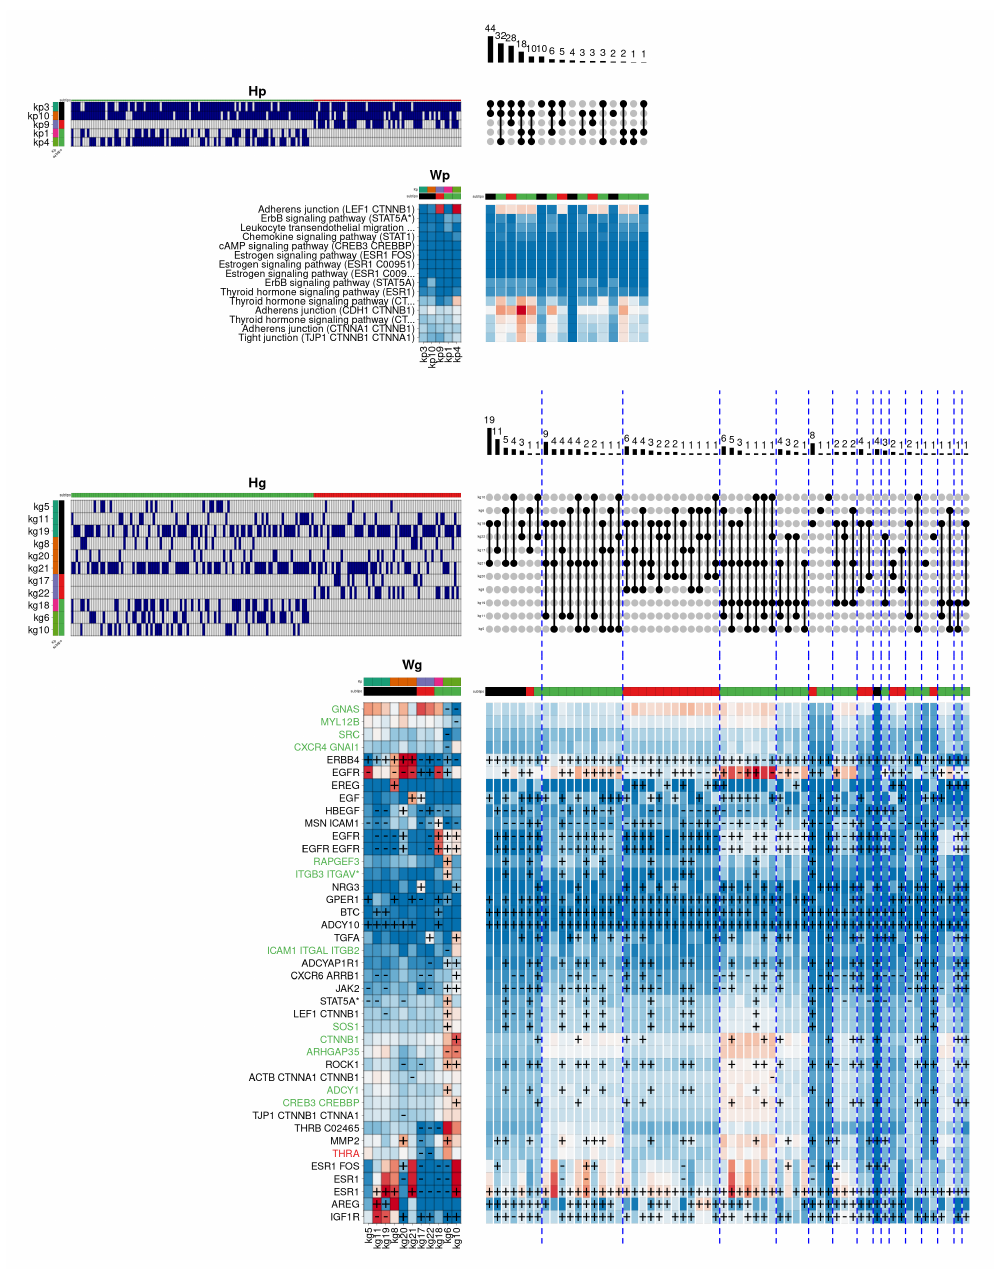
Figure 7. Graphical representation of the hierarchical model obtained in the biological function response to oestrogen , applied to the subtypes Luminal A and Luminal B . The most frequent pathway- level combination is shared between both luminal subtypes, involving the kp3 and kp10 components. These components mainly activate thyroid hormone reception, as well as Adherens junction , Tight junction and ErbB signalling pathways . At the gene level, the associated components activate relevant genes as the growth factor receptors ERBB4 and AREG , as well as ESR1 , one of the oestrogen receptor